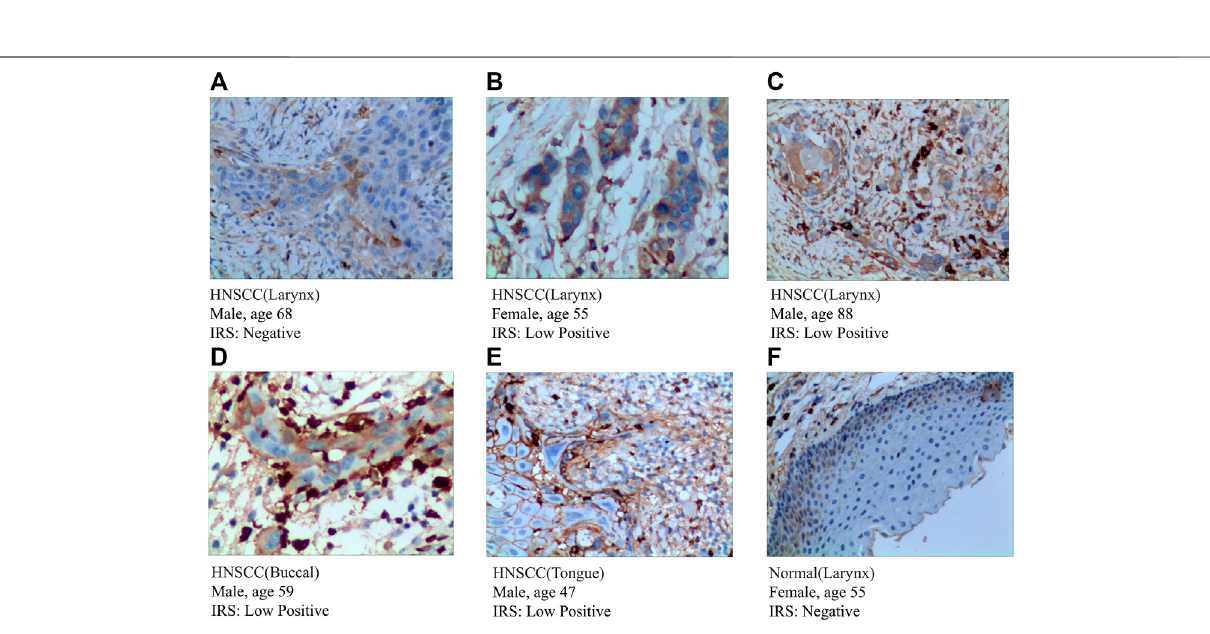
Frontiers in Cell and Developmental Biology |